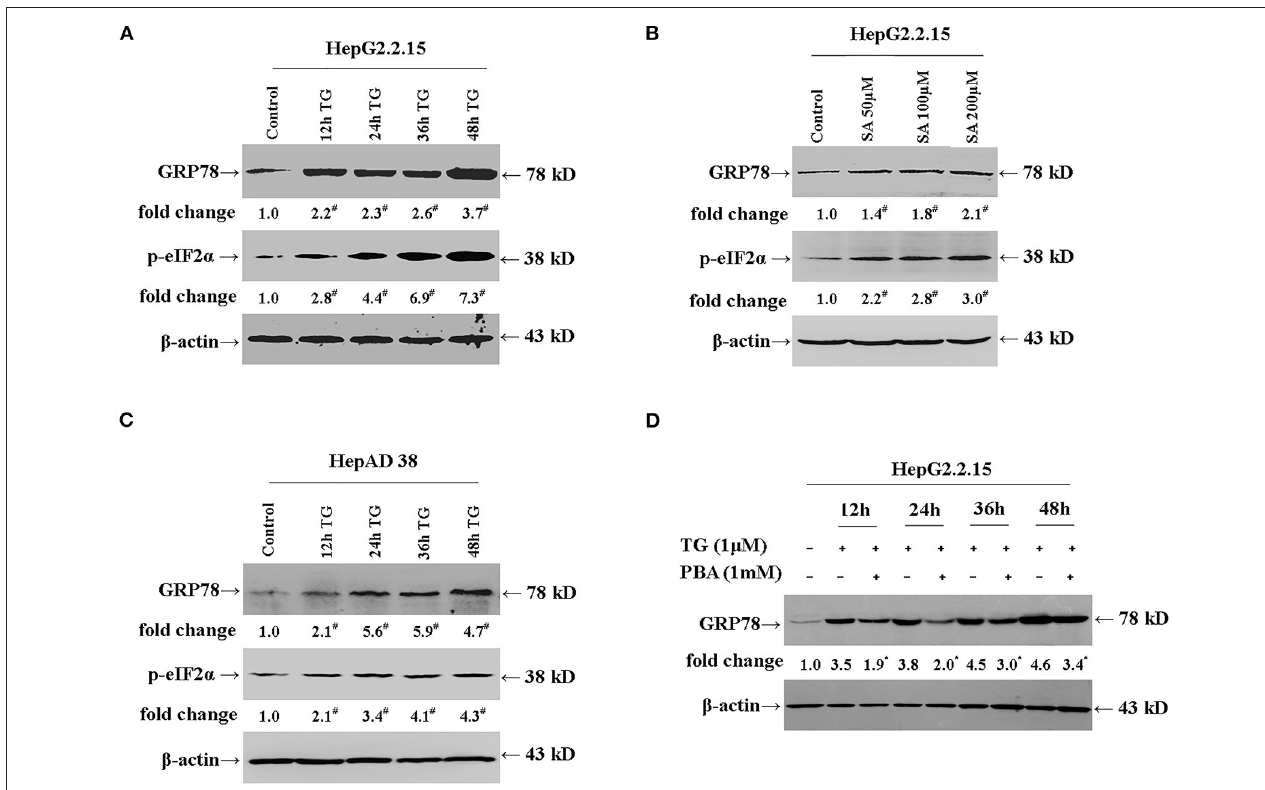
FIGURE 1 | TG and SA induced ER stress in HepG2.2.15 and HepAD38 cells, which was alleviated by PBA treatment. HepG2.2.15 and HepAD38 cells were treated with 1 µ M of TG for 12, 24, 36, and 48h or 50, 100, and 200 µ M of SA for 48h. The expression of GRP78 and p-eIF2 α was assessed by western blotting. Representative blots from three independent experiments are shown. The results of the densitometric analysis are presented as fold-changes compared with control or TG. (A) GRP78 and p-eIF2 α expression in HepG2.2.15 cells after TG treatment. # P < 0.05 vs. control. (B) GRP78 and p-eIF2 α expression in HepG2.2.15 cells following SA treatment. # P < 0.05 vs. control. (C) GRP78 and p-eIF2 α expression in HepAD38 cells after TG treatment. # P < 0.05 vs. control. (D) GRP78 expression in HepG2.2.15 cells after TG or PBA (1mM) + TG treatment. * P < 0.05 vs. the TG group. ER, endoplasmic reticulum; GRP78, glucose-regulated